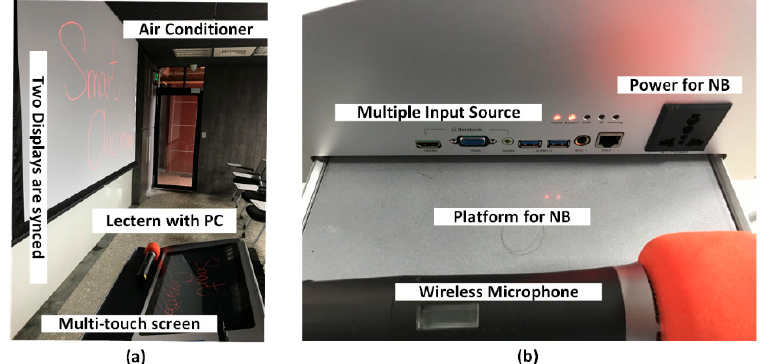
Figure 1. Basic requirements for a comfortable teaching and learning environment: ( a ) a whiteboard for traditional lecture. Chairs with wheels and a tablet for the convenience of notes taking, using a notebook computer, and group discussion, A lectern for teacher with a computer connected to a touch screen and the projector; ( b ) a projector with motorized screen for lecturing with digital contents. Circulation fans and air conditioner for a comfortable learning environment. Lights in different areas can be controlled respectively.